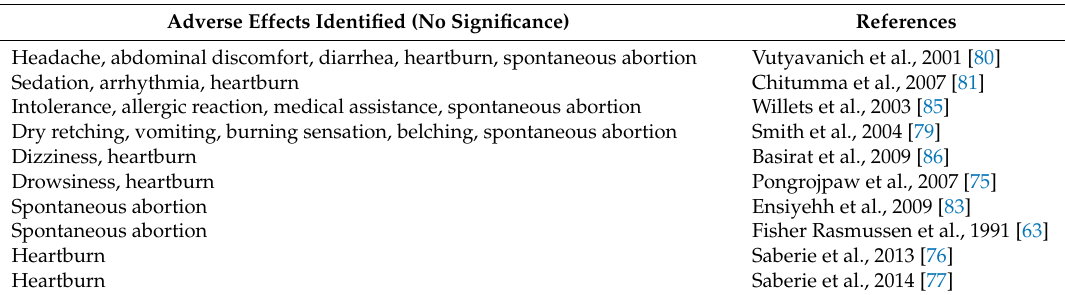
Table 11. List of adverse effects identified in the different clinical